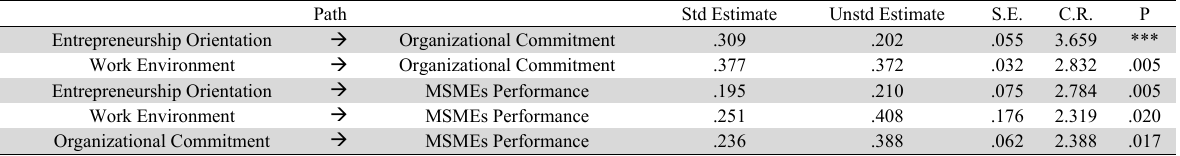
Hypothesis Testing